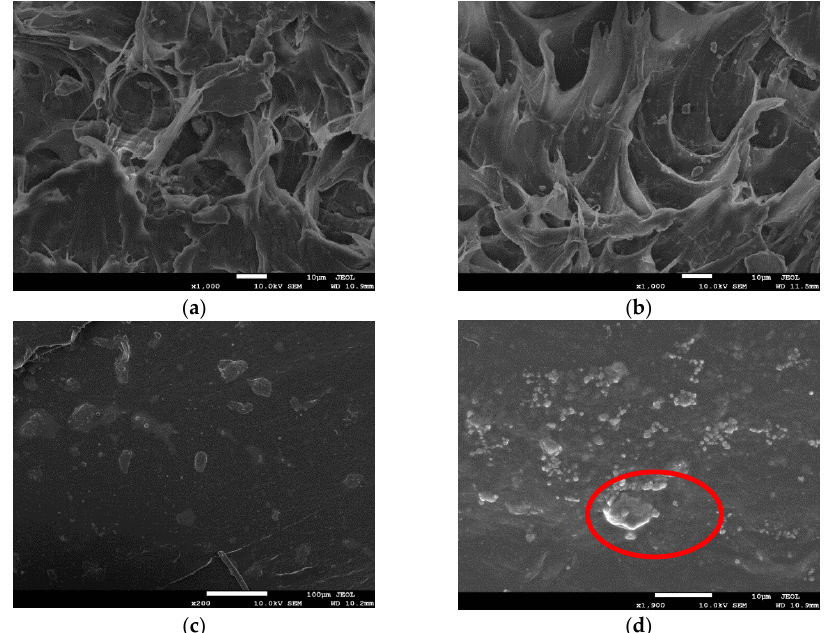
Figure 8. SEM photographs of composites containing: ( a ) HDPE/FA masterbatch (5 wt.%); ( b ) HDPE – FA masterbatch (10 wt.%); ( c ) HDPE – FA masterbatch (10 wt.%) compatibilized with 5% HDPE-g-MAH; ( d ) HDPE – FA masterbatch (15 wt.%). Table 5. Thermogravimetric Analysis of FA/HDPE Composites. Blend